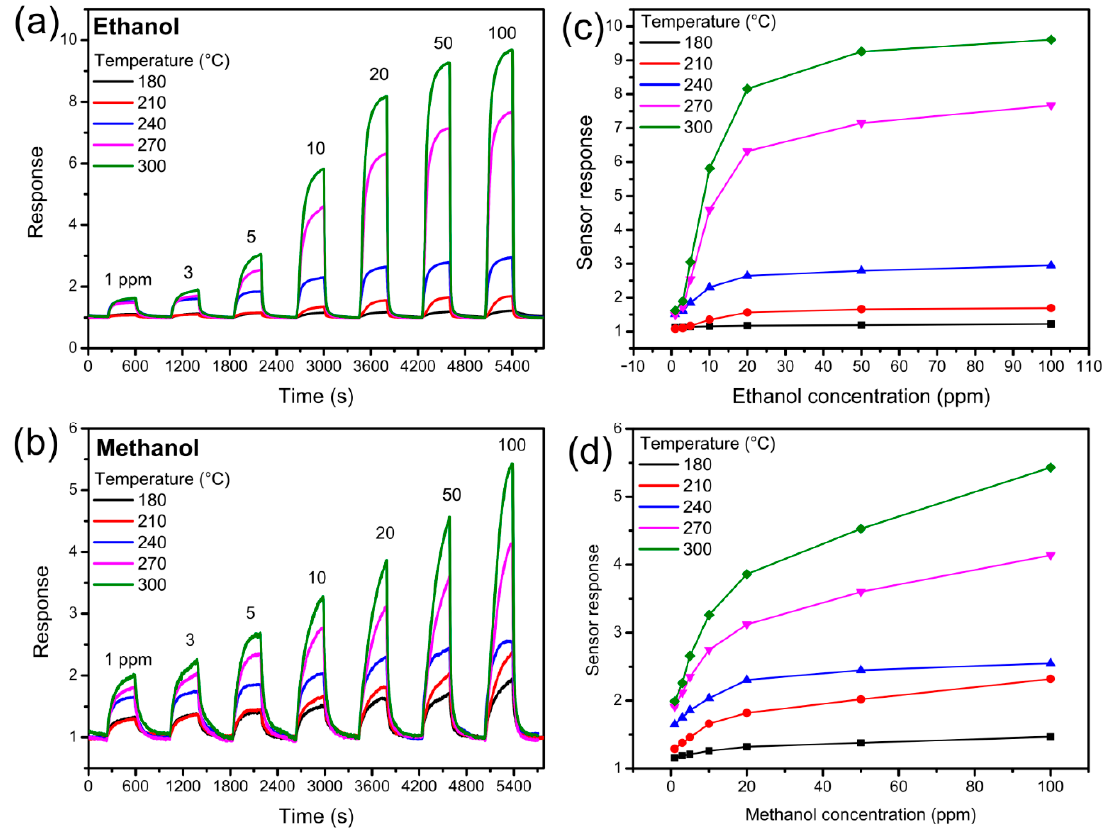
Figure 2. Dynamic response of the sensor to different concentrations of ( a ) ethanol and ( b ) methanol at different temperatures; response as a function of gas concentration for ( c ) ethanol and ( d ) methanol at different operating temperatures.